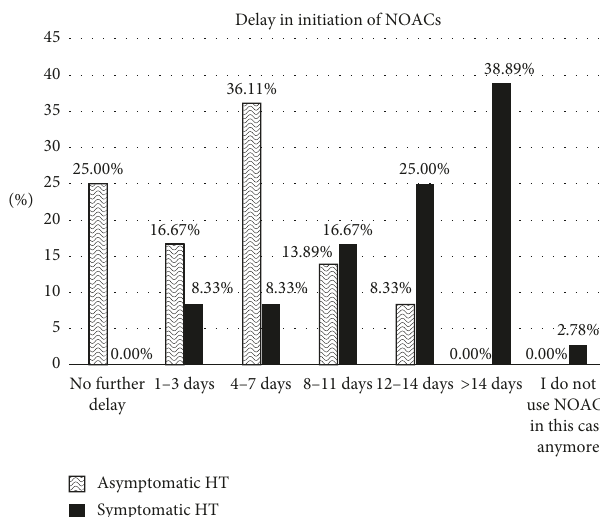
Figure 2: Participants’ responses to the question of how many days they would further delay the initiation of NOACs if a pre-NOACs CT head shows hemorrhagic transformation (HT) of the index